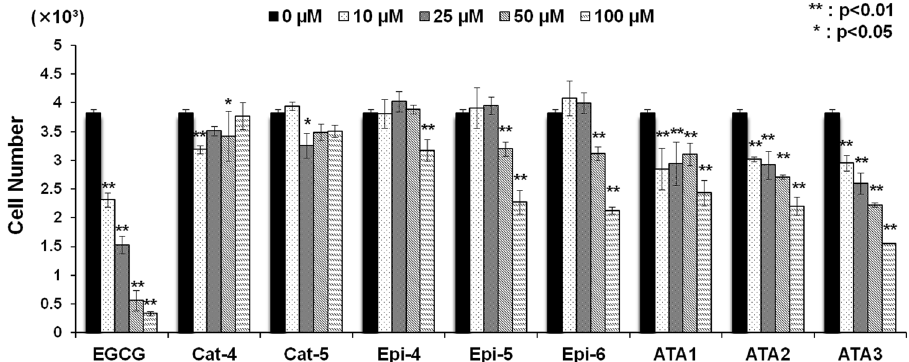
Figure 5. Effects of various concentrations of test compounds on PC-3 prostate cancer cell proliferation. Effects of various concentrations of test compounds on PC-3 cancer cell proliferation using a cell count method. The experimental procedure for preparation of test compounds was described in Biochemical methods of Supplementary Information. After treatment of cells with either the catechin tetramer (Cat-4), catechin pentamer (Cat-5), cinnamtannin A2 (Epi-4), cinnamtannin A3 (Epi-5), cinnamtannin A4 (Epi-6), arecatannin A1 (ATA1), arecatannin A2 (ATA2) or arecatannin A3 (ATA3) for 48 h, cell proliferation was determined by cell counting as shown in the experimental section. The values are presented as the rate of inhibition of cell proliferation by the treated sample when compared with that of the untreated control (vehicle). Values are means ± S.Ds. for three independent experiments. Two-way ANOVA followed by Dunnett’s multiple comparison test was used to compare means. * P < 0.05 or ** P <